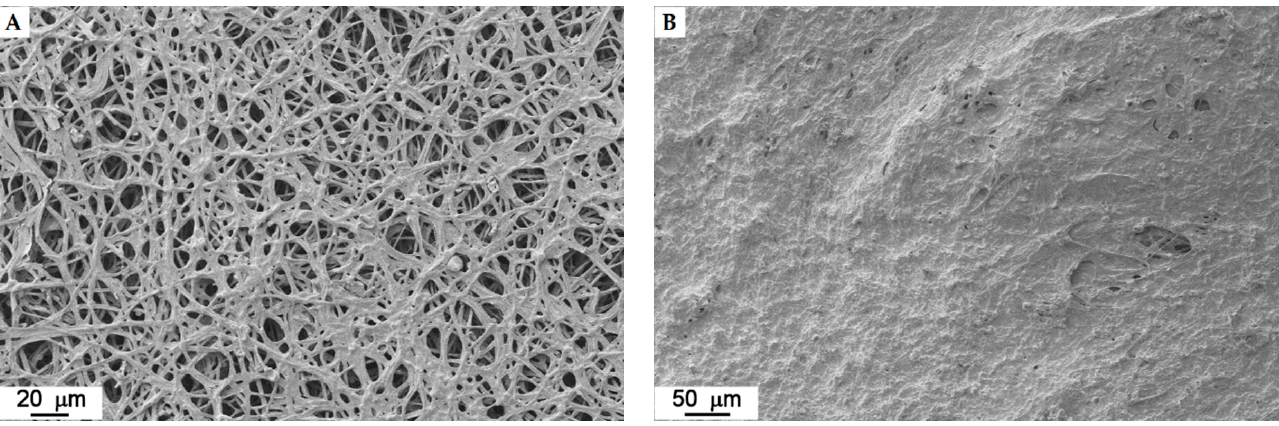
Figure 11. Irpiciporus pachyodon ( 15). Front ( A ) and back ( B ) of the mat obtained by patented method.